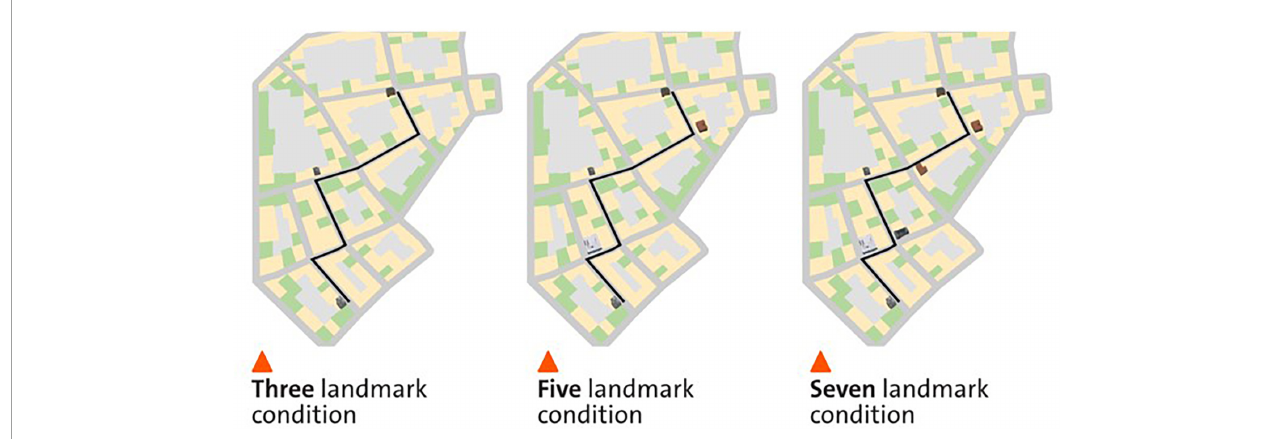
FIGURE1 The three different landmark conditions in a virtual city. The left , middle , and right panels depict the map condition with three, five, and seven landmarks displayed on the mobile map, respectively. The figure is adapted from Cheng et al.